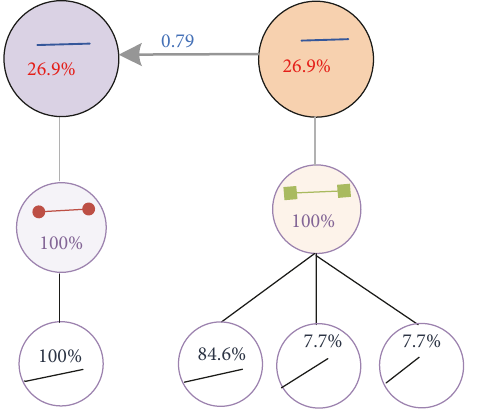
Figure 7: A simple example of the probabilities within and among travel association map.